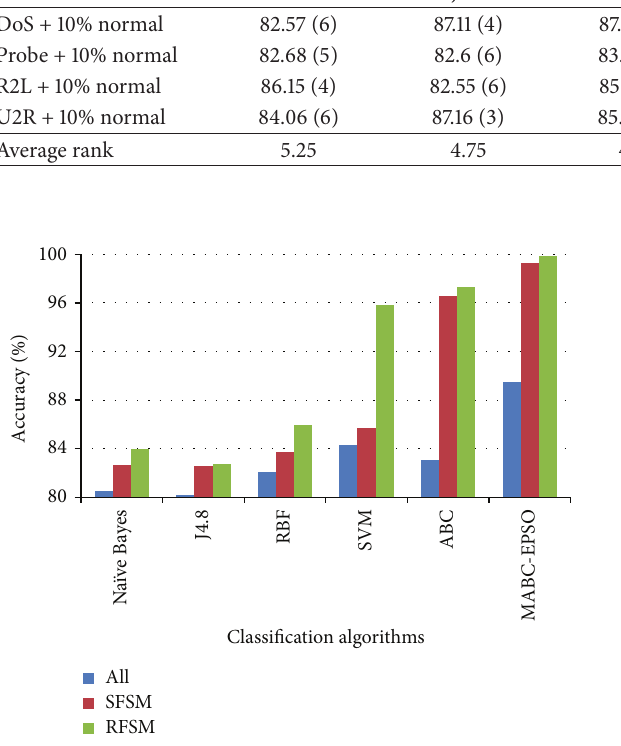
Figure 6: Accuracy comparison of classifiers for U2R